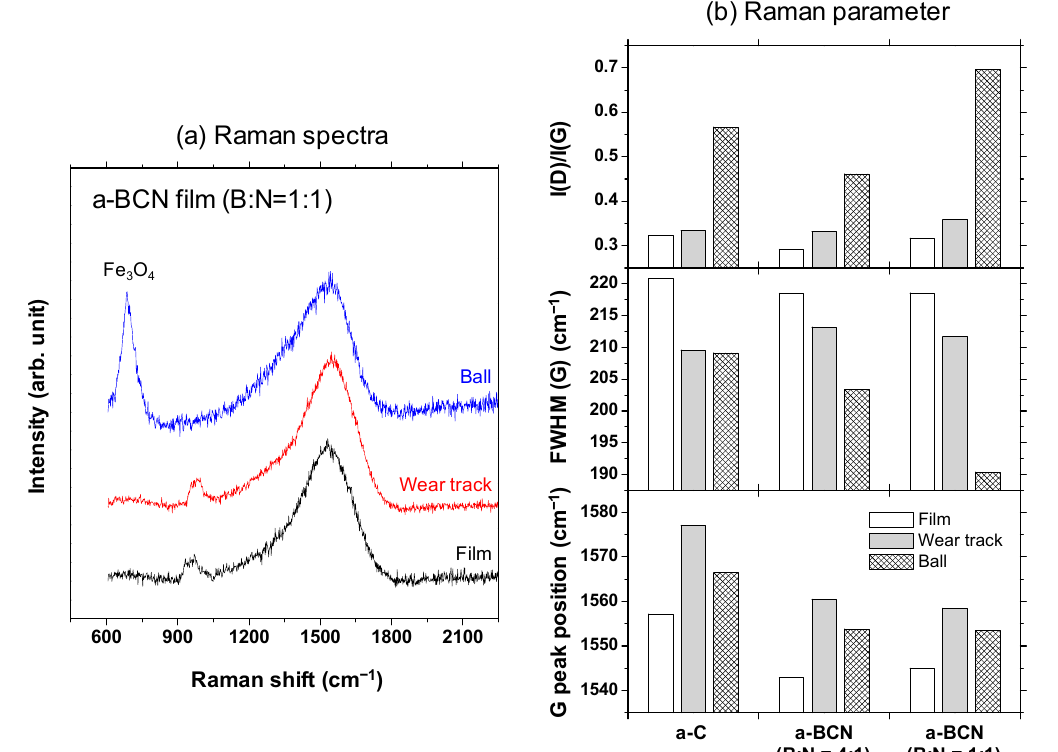
Figure 13. ( a ) Raman spectra of the surface of the as-deposited film, wear track, and ball sample and the corresponding ( b )